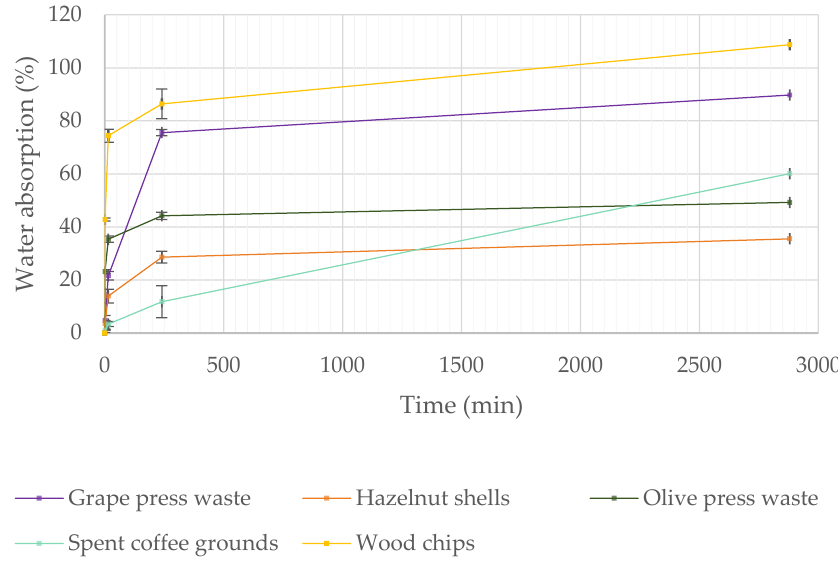
Figure 5. Correlation between thermal conductivity and loose bulk density of bio-wastes [31 – 33,58,64].